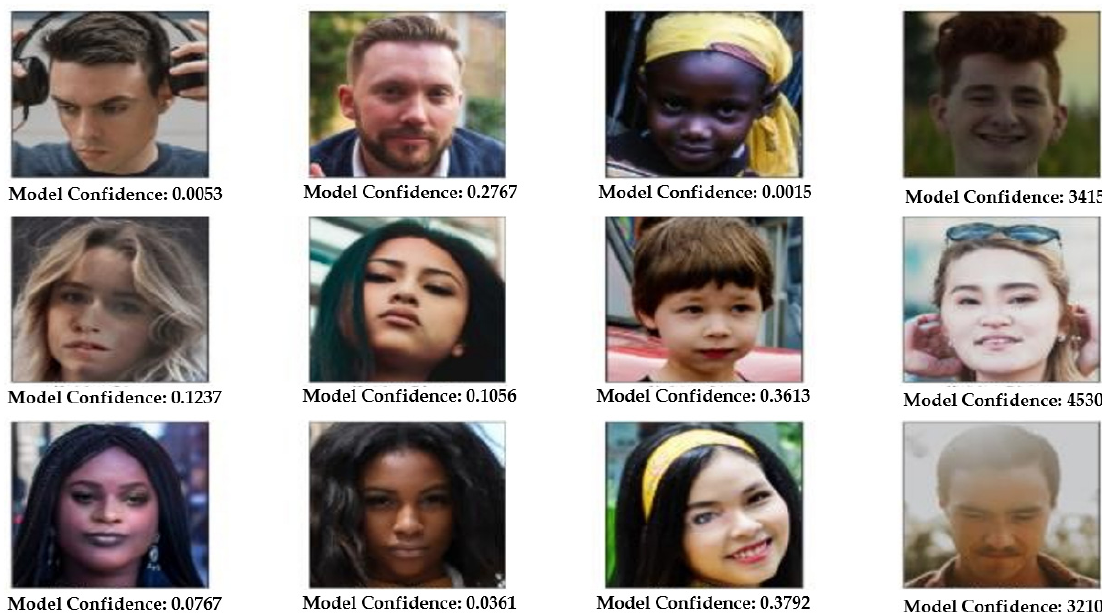
Figure 7. Correct DeepFake prediction: showing the model confidence in the prediction.